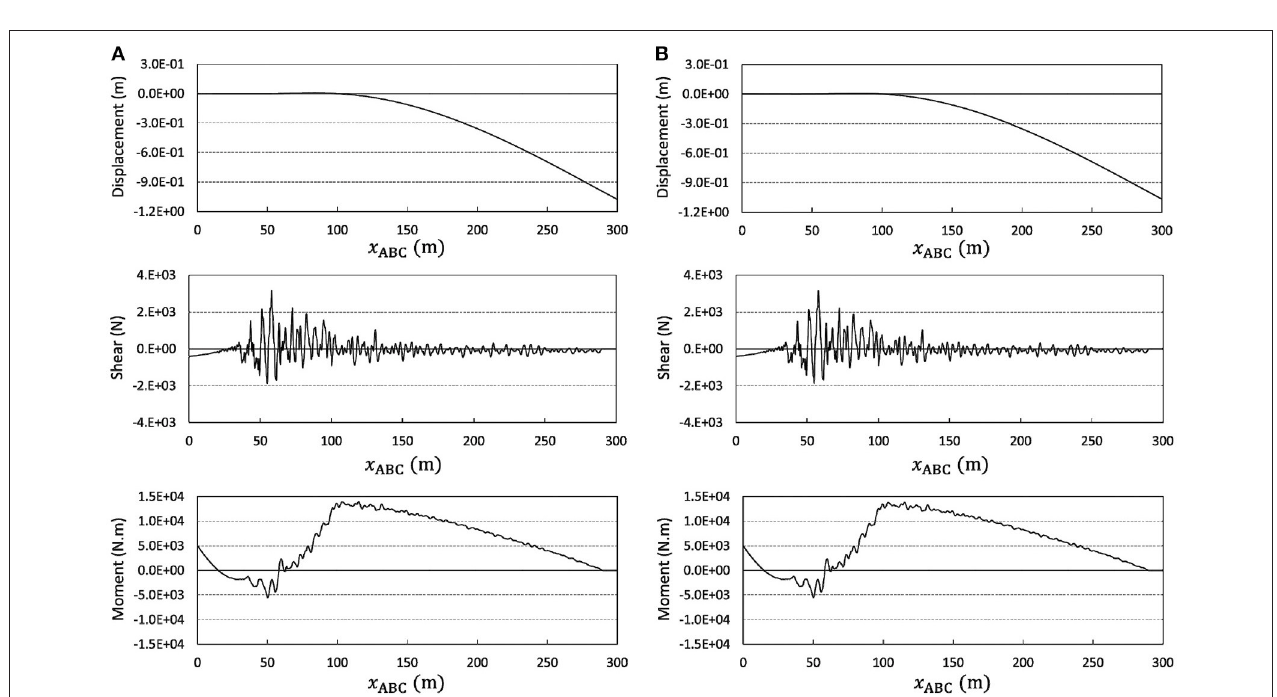
FIGURE 8 | Responses of the third example obtained from analysis with elements sized (A) f 1 x and (B) 4 f 1 x .